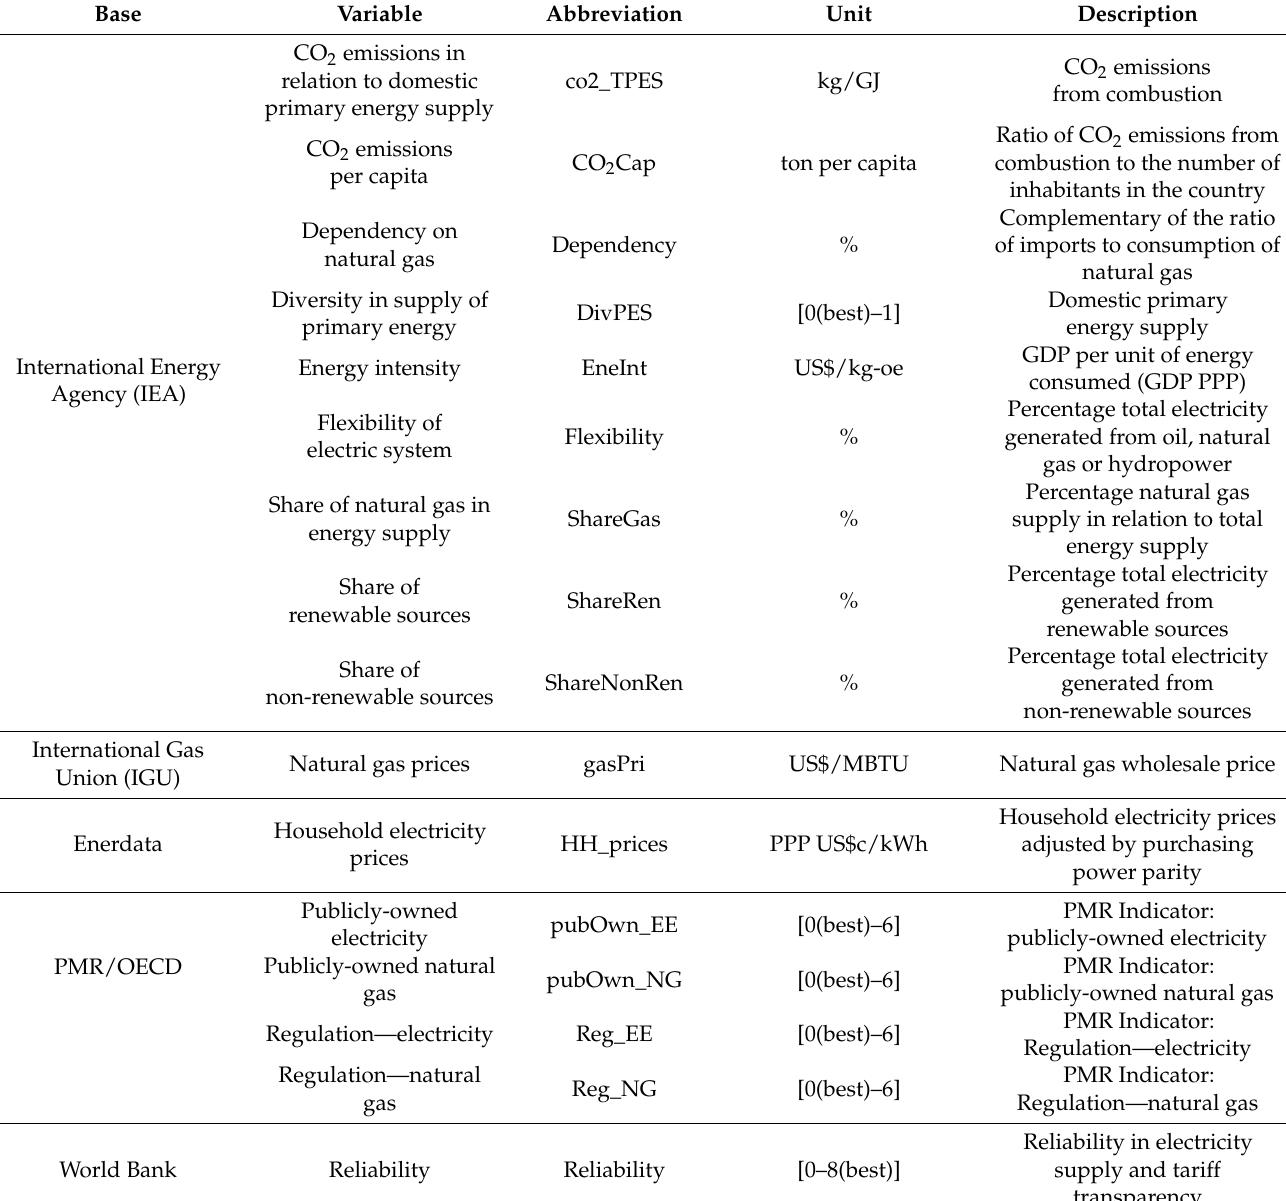
Table 1. Variables analyzed. Source: Drawn up by the authors.